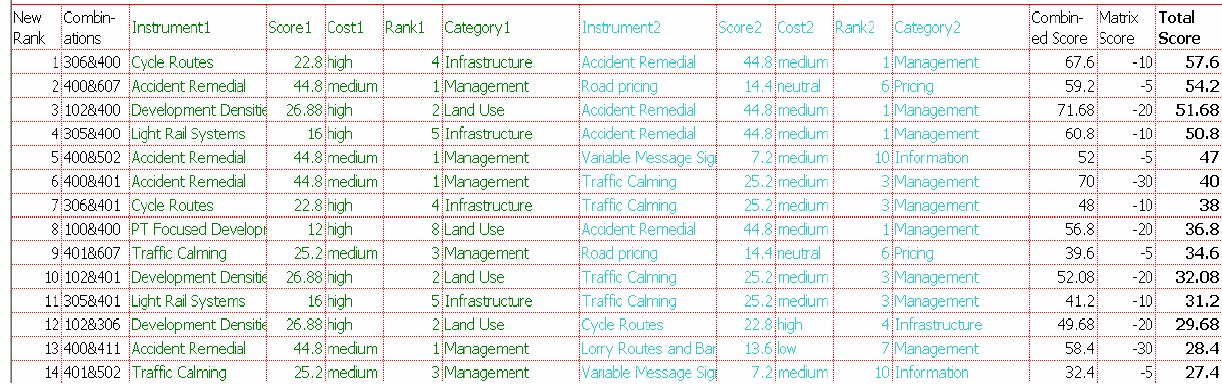
Figure 6. Output file showing most highly ranked combinations Source: Kelly et al (2008b), Figure